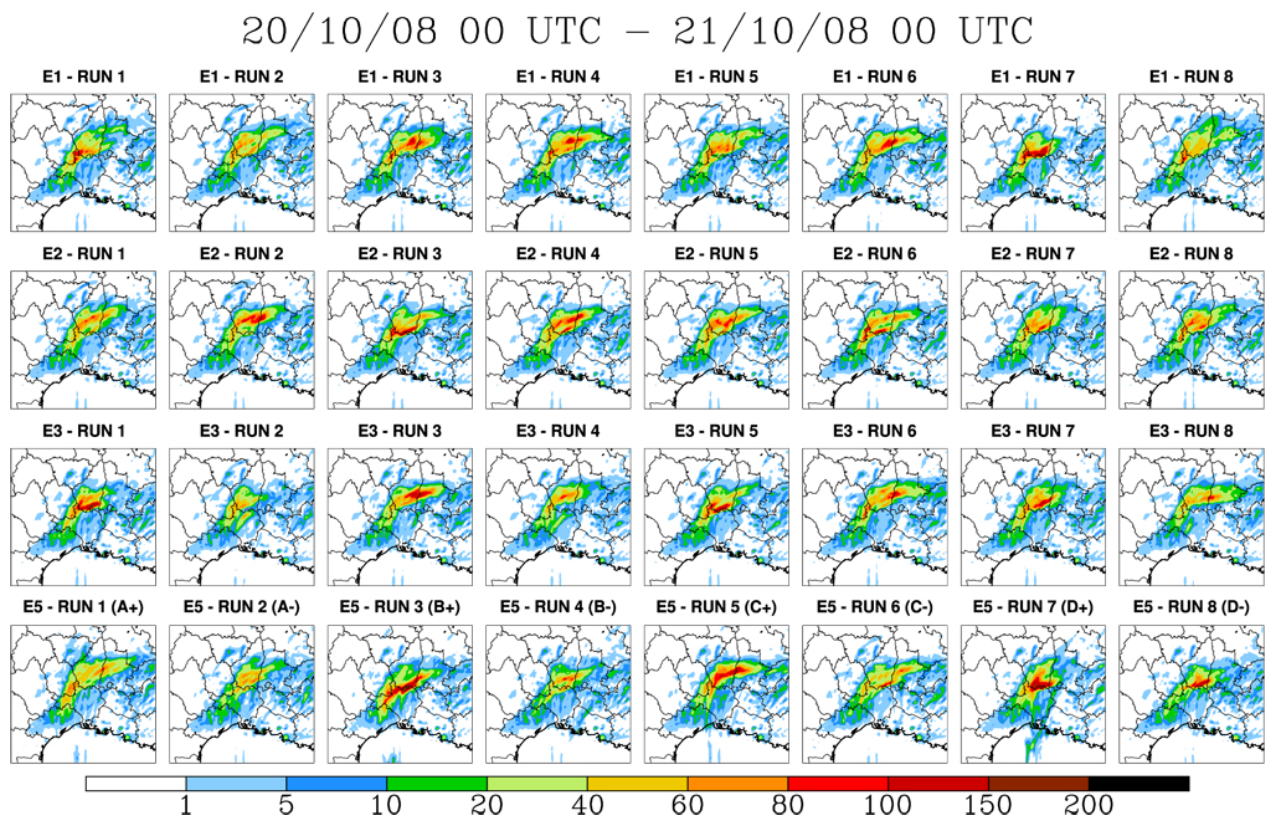
Fig. 6. 24-h accumulated precipitation computed for the Gard-H´erault case. The E1, E2, E3 and E5 perturbed ensemble members are displayed from top to bottom. The E1 members are ordered with increasing N or . For the E5 members, the location (A, B, C, and D as shown in Fig. 11) and sign ( ± ) of the perturbation are indicated in parenthesis. See Fig. 2d for the reference run.